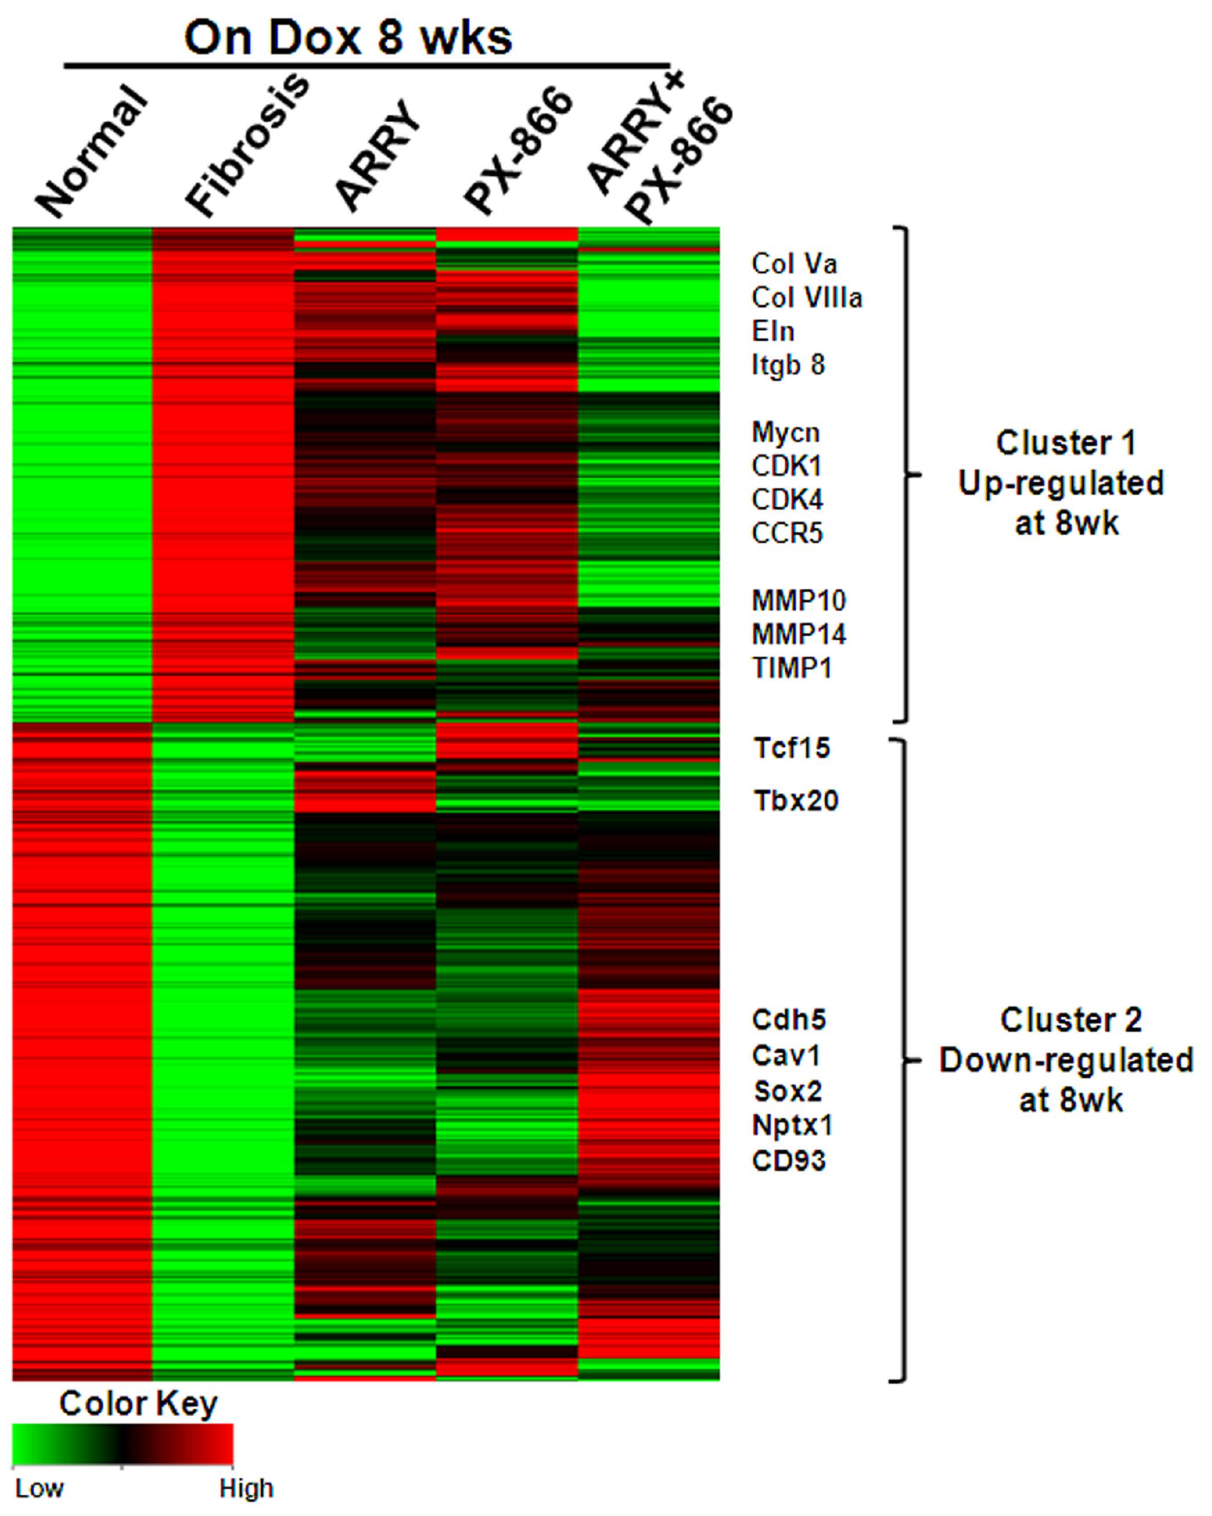
Figure 6. Inhibition of MEK and PI3K alone or in combination alters the transcriptome of the lung during TGF a -induced pulmonary fibrosis. Heatmap depicting expression levels of total lung genes with at least a two-fold change from CCSP/ 2 control mice on Dox for 8 wks. Differentially expressed genes (up- or down-regulated) by $ two-fold in the fibrosis, ARRY, PX-866, ARRY/PX-866 in combination treatment groups are shown. Expression levels of these genes were either maintained or enriched in the combination group as compared to both single inhibitors. Several known fibrotic genes that are significantly down regulated in combined therapy are highlighted using their gene symbols.